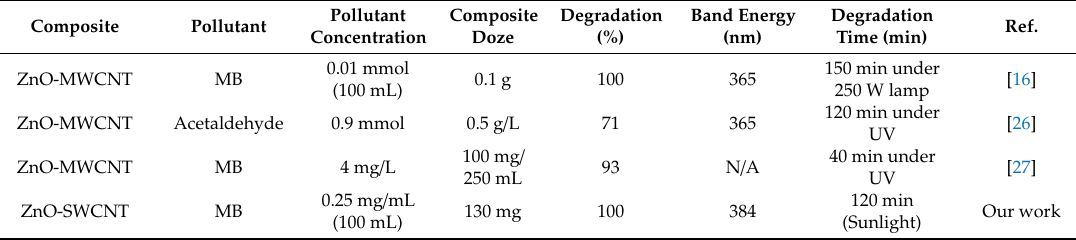
Table 1. Comparison of photocatalytic e ffi ciency of composites involving ZnO-CNTs. Pollutant Composite Composite Pollutant Concentration